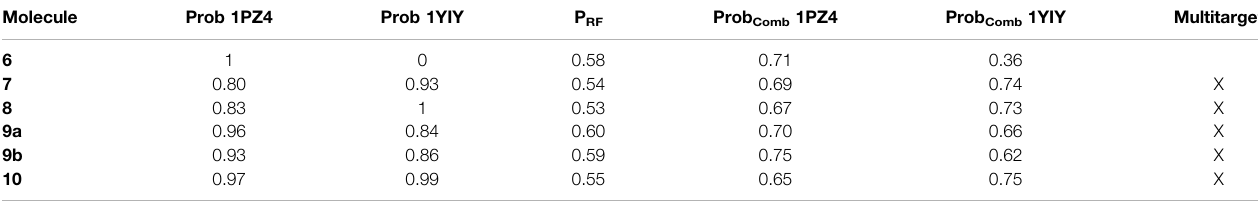
TABLE 4| Summaryoftheresultsofthemolecular docking of fl avonoidsforproteins1PZ4and1YIY,probabilityoftheRFmodel,andcombinedprobabilityofthetwovirtual screening techniques. Molecule Prob 1PZ4 Prob 1YIY P